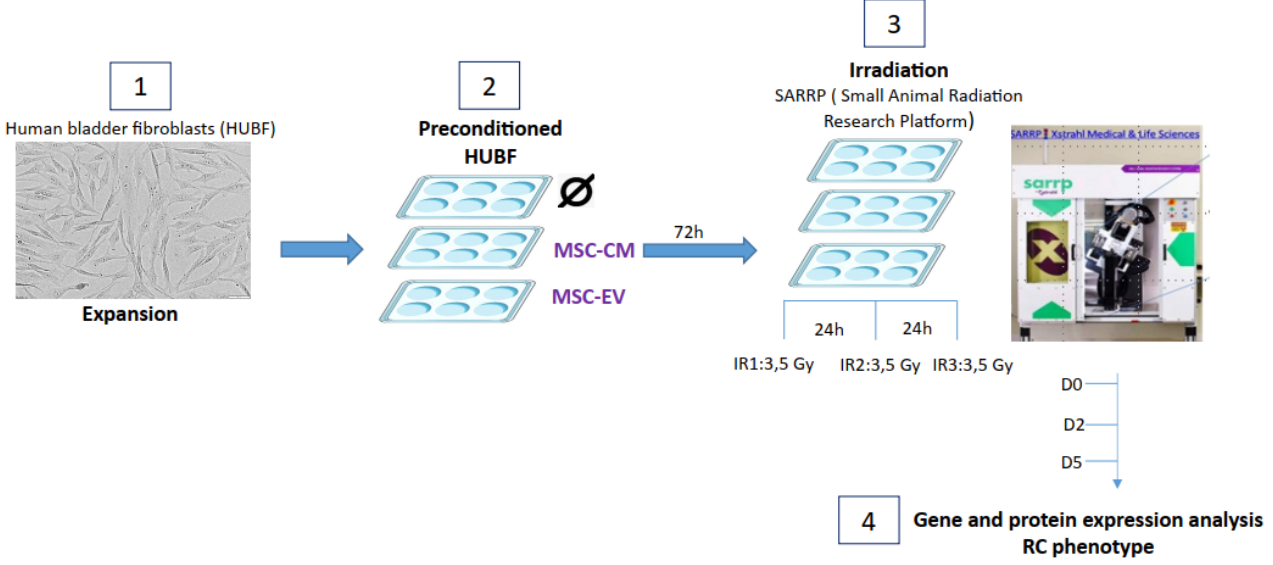
Figure 2. Representation of the 4 steps for obtaining an in vitro model of radiation cystitis (RC): ( 1 ) culture and expansion of HUBFs, ( 2 ) 72 h of preconditioning of HUFBs (control without condi- tioning (Ø)), with MSC-CM) or with (MSC-VE), ( 3 ) 3 irradiations of HUBFs at a dose of 3.5 Gy at 24 h intervals, using the Xstrahl small animal radiation research platform (SARRP), ( 4 ) harvest of su- pernatants and cells at 0, 2 and 5 days after last exposure (for gene and protein expression analysis).